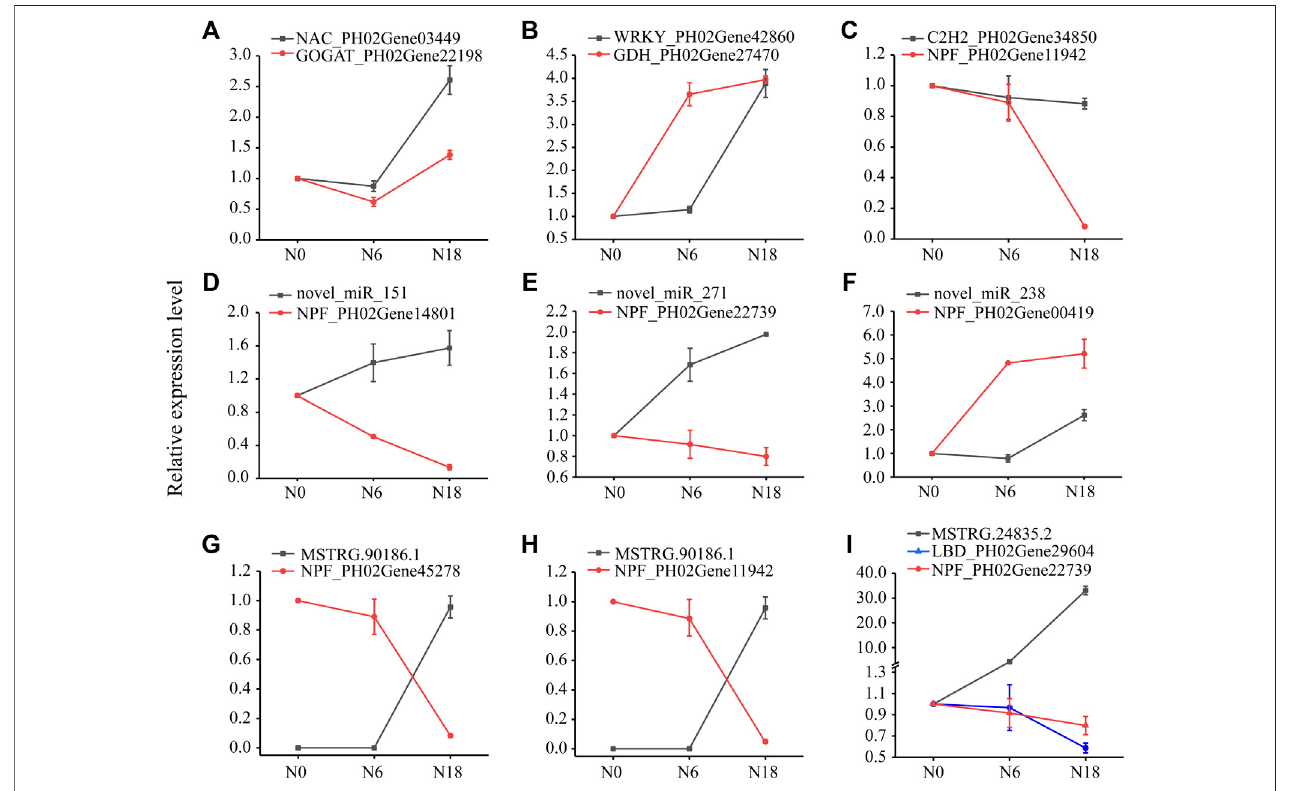
FIGURE 8 | Expression analysis of genes, miRNAs, and lncRNAs using qPCR. Data are means ± SD of three replicates ( n = 3): (A) NAC-GOGAT pair; (B) WRKY- GDH pair; (C) WRKY-GDH pair; (D – F) miRNA-NPF pairs; (G – H) lncRNA-NPF pairs; and (I) lncRNA-LBD-NPF